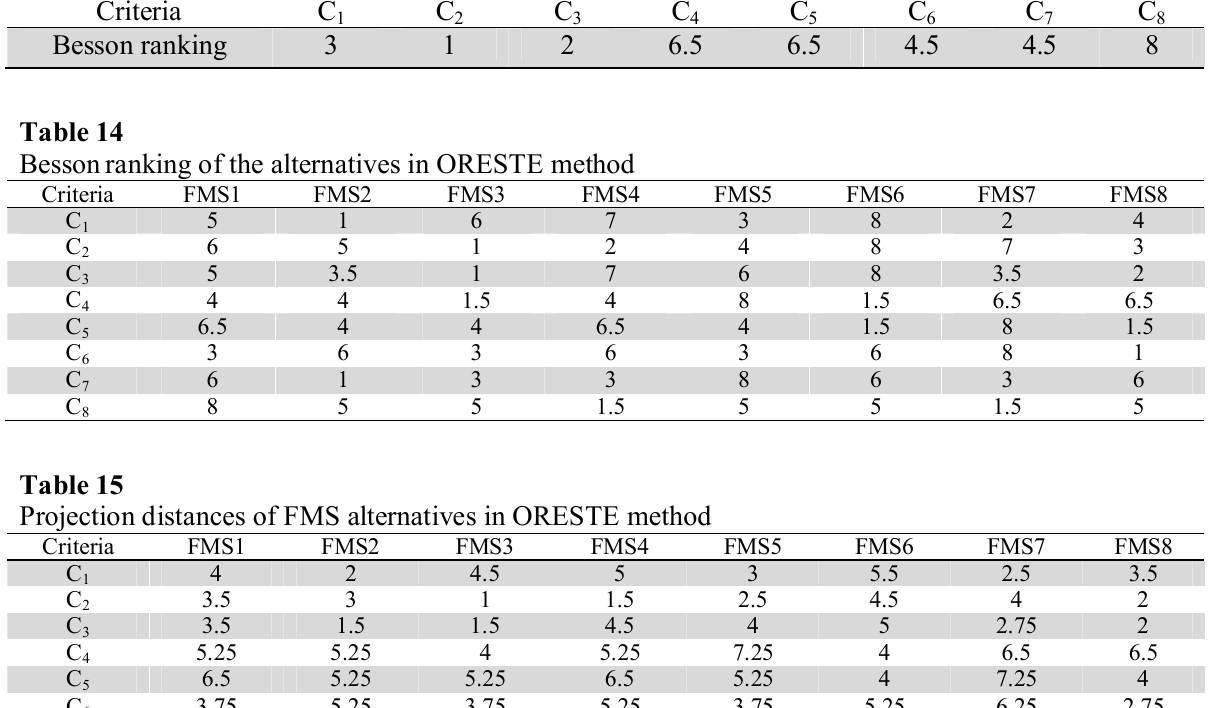
Besson ranking of criteria in ORESTE method Criteria